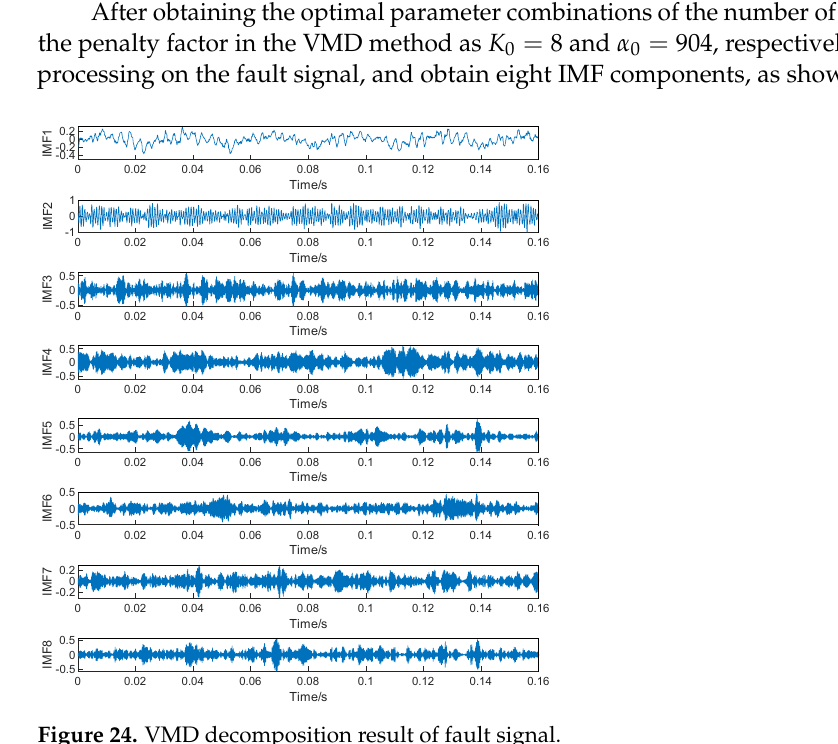
Figure 24. VMD decomposition result of fault signal. Calculate the peak factor value of the envelope spectrum of each IMF component in the above figure; the result is shown in Figure 25.